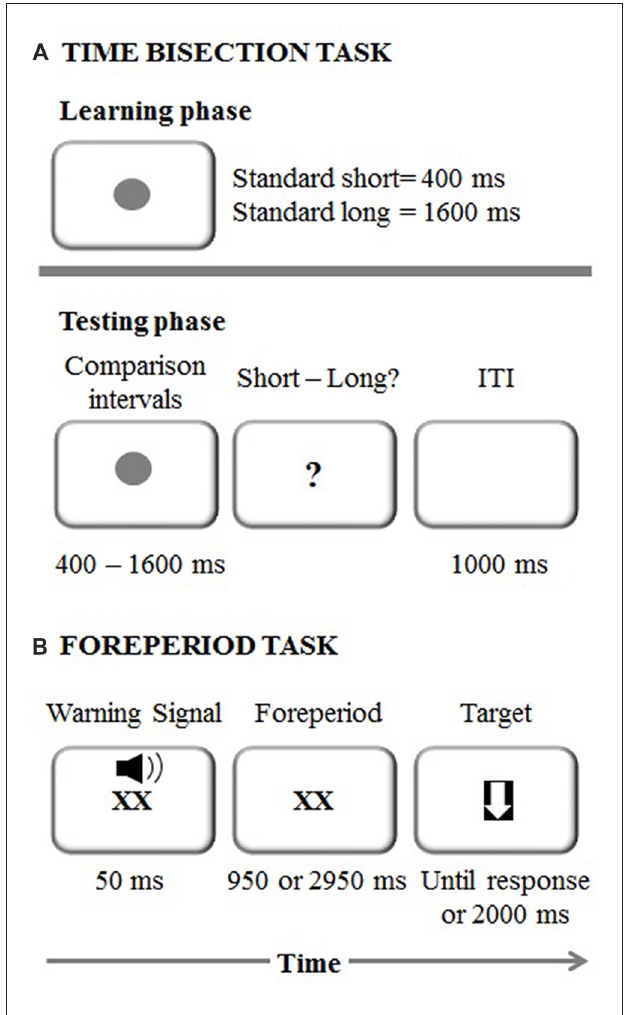
FIGURE 1 | (A) Experimental procedure representing the time bisection task. ITI stands for Inter-Trial Interval (B) Experimental procedure representing the foreperiod